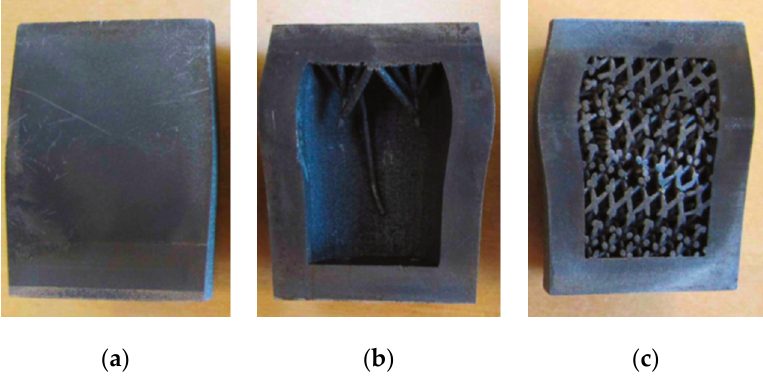
Figure 4. Deformation of samples in compression test [88]: ( a ) solid; ( b ) hollow; ( c ) lattice.